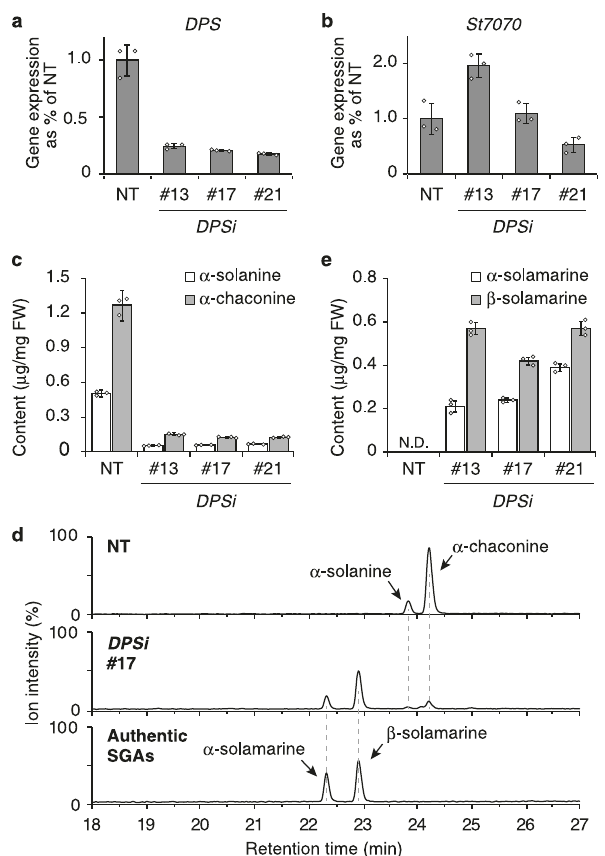
Fig. 3 Silencing of DPS in potato plants. Real-time quantitative RT-PCR analysis of DPS ( a ) and St7070 ( b ) gene transcript levels in non- transformed and DPS -silenced ( DPSi ) potato plants. c Quanti fi cation of solanidane SGAs accumulated in non-transformed and DPSi plants using LC – MS. d SGA pro fi les determined by LC – MS. Total ion current chromatogram obtained in positive ionization mode with a full-scan range of 350 – 1250 m/z are shown. Accumulation of α -solamarine and β - solamarine was con fi rmed by comparison with authentic standards in terms of retention time and mass spectrum provided in Supplementary Fig. 7. e Quanti fi cation of spirosolane SGAs accumulated in non-transformed and DPSi potato plants. Error bars represent ± standard deviation of mean ( n = 3). FW fresh weight, NT non-transformed control plant, ND not detected, #13, #17, #21 independent transgenic